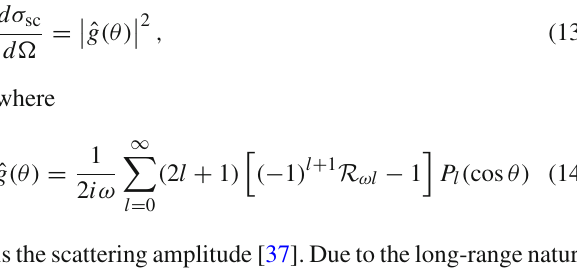
panel and non-positive values on the bottom panel).